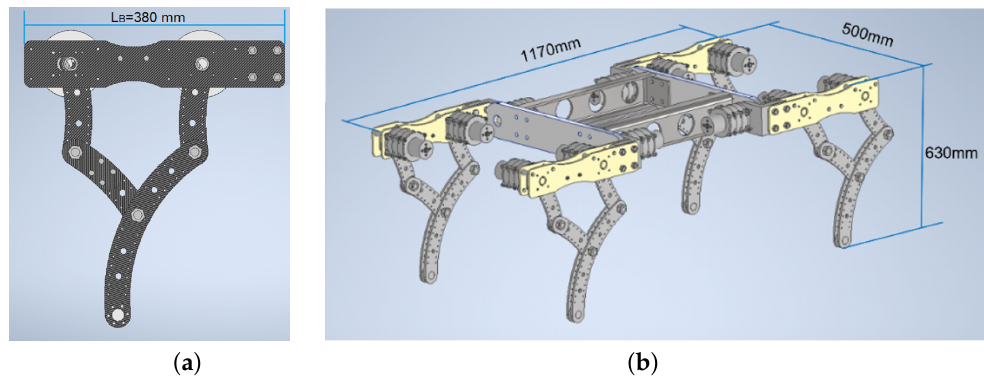
Figure 1. ( a ) Leg mechanism 2 D.O.F.-5R. ( b ) Robot